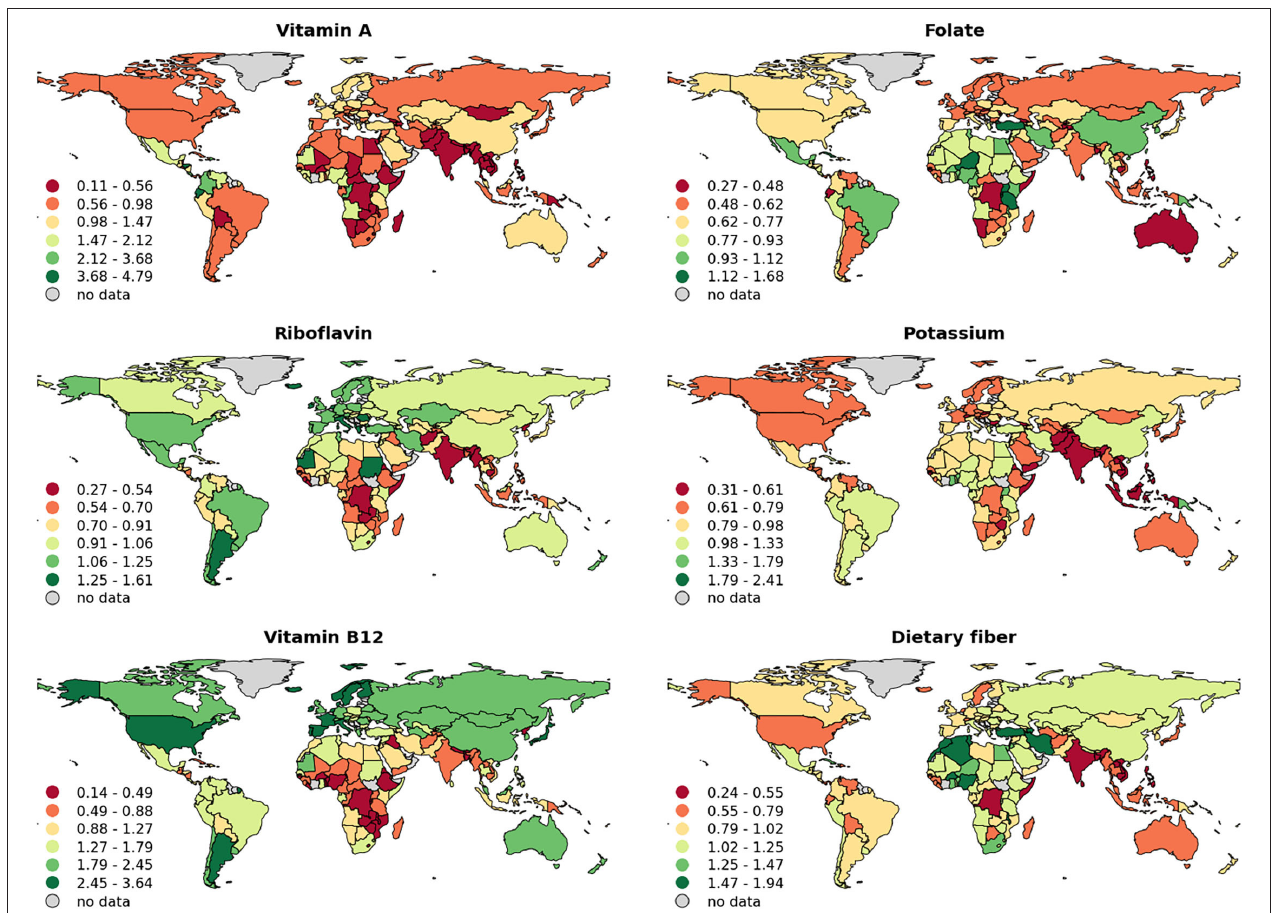
FIGURE 2 | Ratio of current dietary supply to recommended intake for selected nutrients. Recommendations are population level average Reference Nutrient Intake (RNI) per capita per nutrient for each country which are calculated following the methods in Chen et al. (2020). Current intake levels (year 2010) were adopted from Springmann et al.